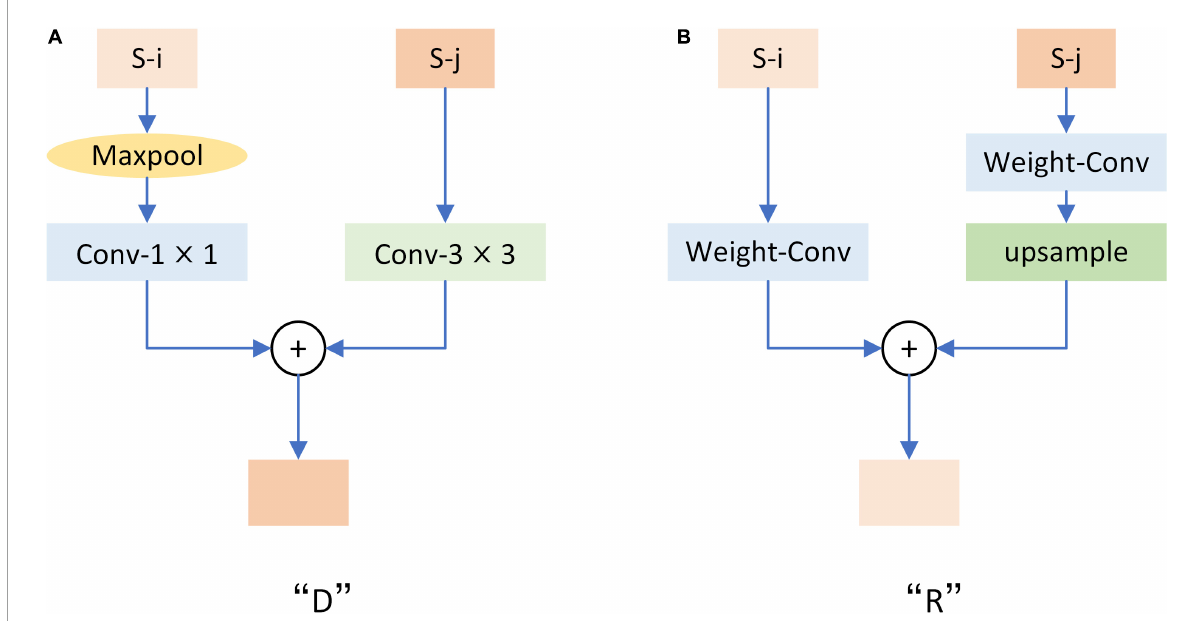
FIGURE6 Structure diagram of “D” and “R” modules. Where S-i and S-j represent feature maps with adjacent resolution sizes. (A) Is the structural drawing of module “D”. (B) Is the structure diagram of the “R” module. Each convolution is activated by